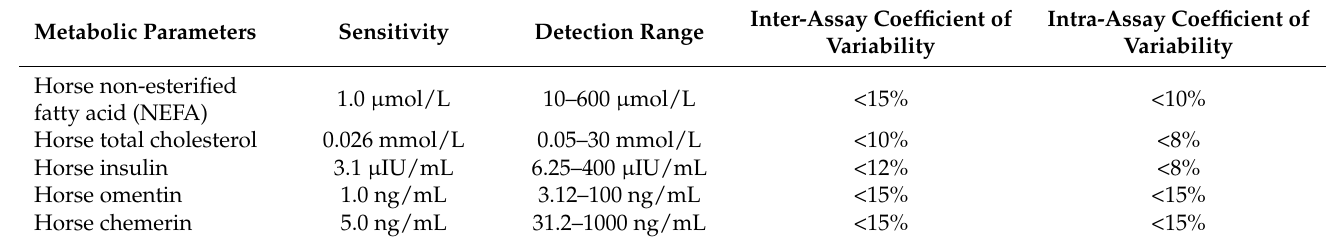
Table 1. ELISA kits’ characteristics according to the manufacturers’